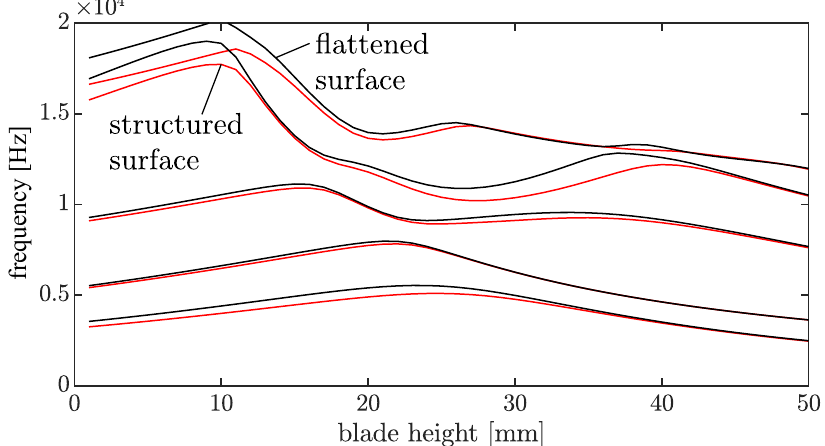
Figure 6. The natural frequencies as a function of the blade height calculated by the FEA for ideally rigid constraints at the flattened (black) and the structured (red) clamping